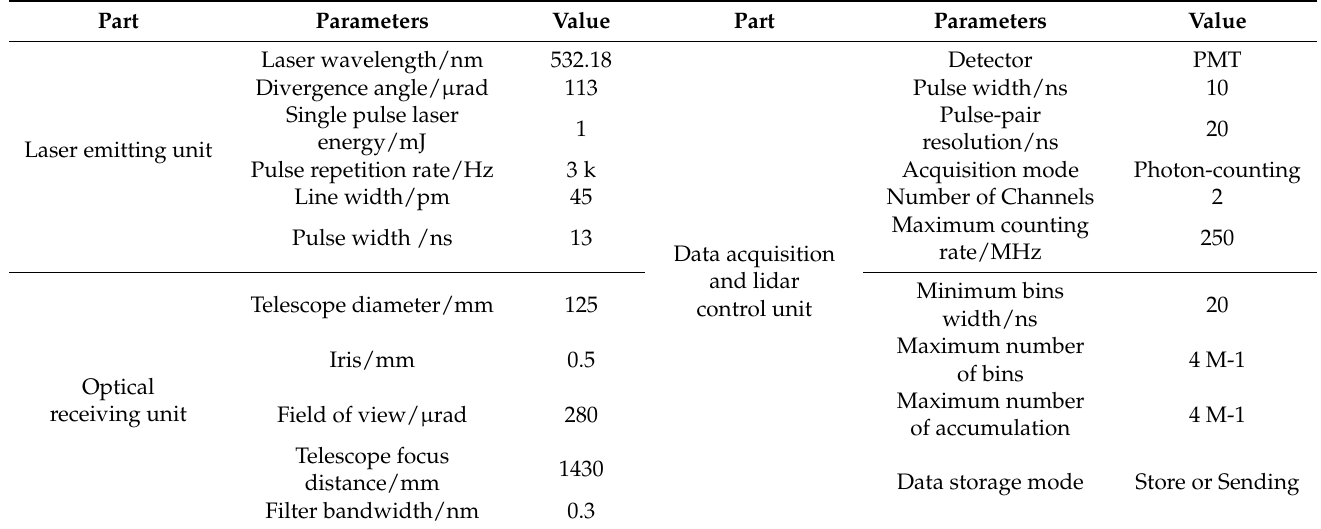
Table 2. Main parameters of